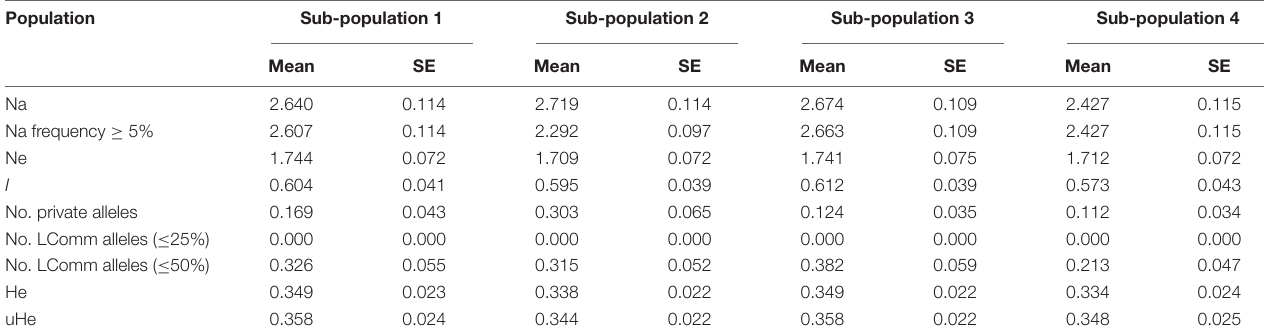
FIGURE 3 | Bar graph representing population genetic structure of mung bean genotypes performed by admixture method in STRUCTURE. TABLE 4 | Genetic diversity and mean allelic pattern across subpopulations of mung bean genotypes. Population